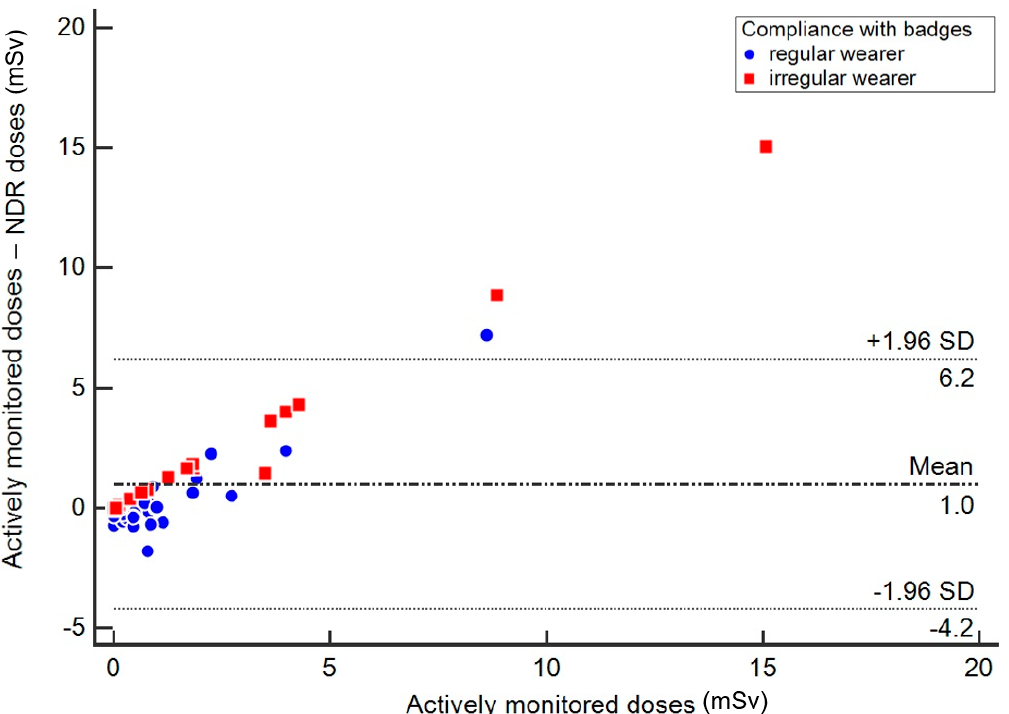
Figure 2. Modified Bland–Altman plot of the difference between actively monitored doses and NDR (national dose registry) doses. Regular wearers are defined as those wearing the KCDC (Korea Centers for Disease Control and Prevention) NDR badge for 75% or more of the time during their practice, and irregular wearers are defined as those wearing the KCDC NDR badge for less than 75% of the time during their practice.